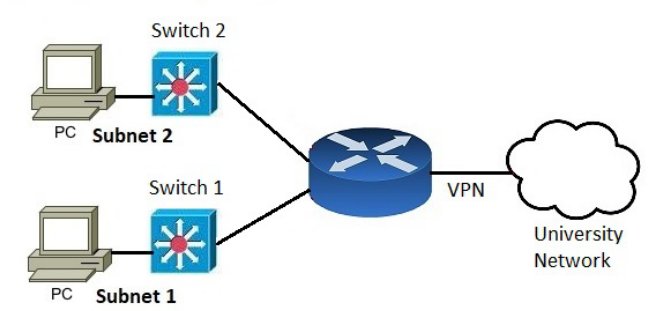
Figure 6. Potential challenges and Configuration issues: Experiment